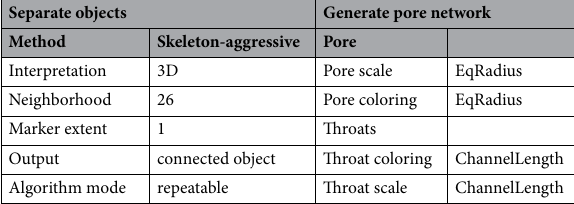
Table 4. The module parameters employed in “Separate Objects” and “Generate Pore